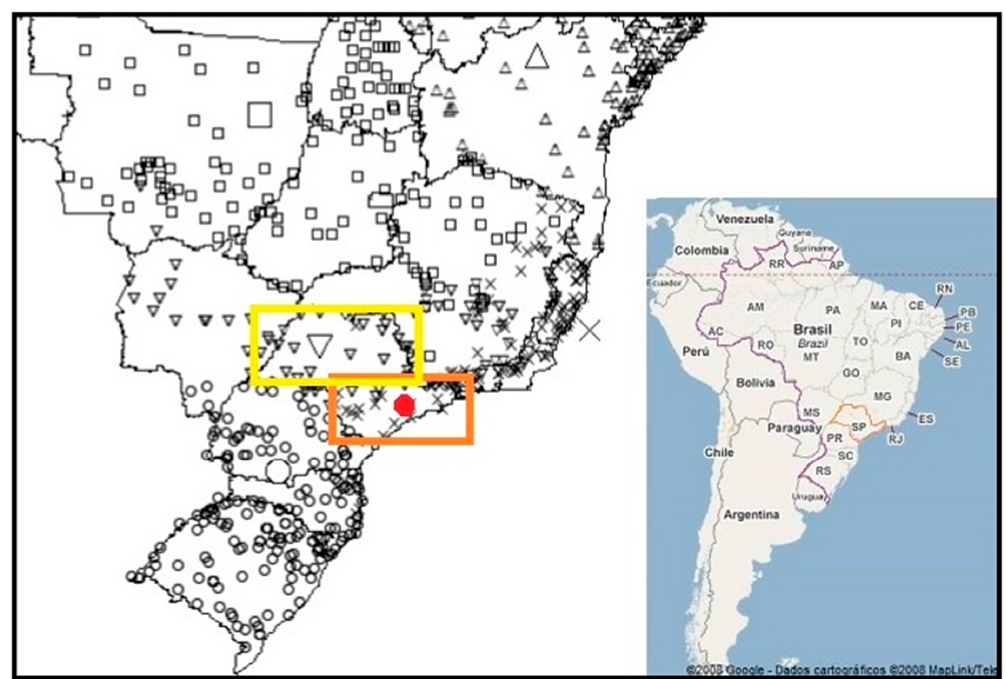
Figure 1. Location of Sao Paulo state (SP) in Brazil and South America (detail). In the bigger map, the city of Sao Paulo (red dot), the ESP region (orange rectangle) and the CWSP region (yellow rectangle) are shown. The symbols (crosses, inverted triangles, etc.) represent different homogeneous rainfall regions. Figure adapted from Keller-Filho et al. [36].